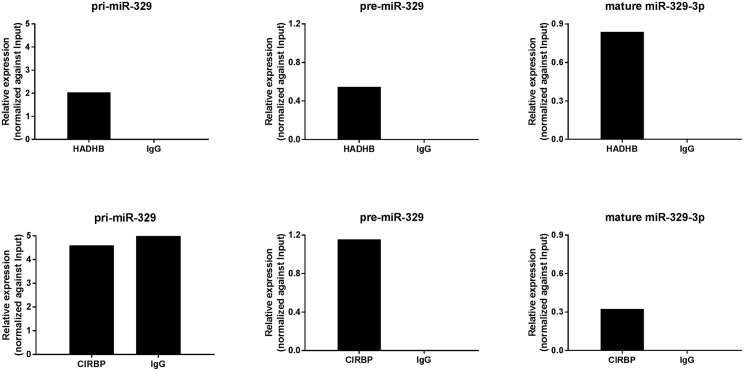
RNA Binding Protein Immunoprecipitation with HADHB and CIRBP AntibodiesPri-miR-329, pre-miR-329, and mature miR-329 expression levels were measured in 3T3 cell lysates after immunoprecipitation with HADHB (top) and CIRBP (bottom) antibodies and non-specific IgG antibody. Bars represent technical triplicates.